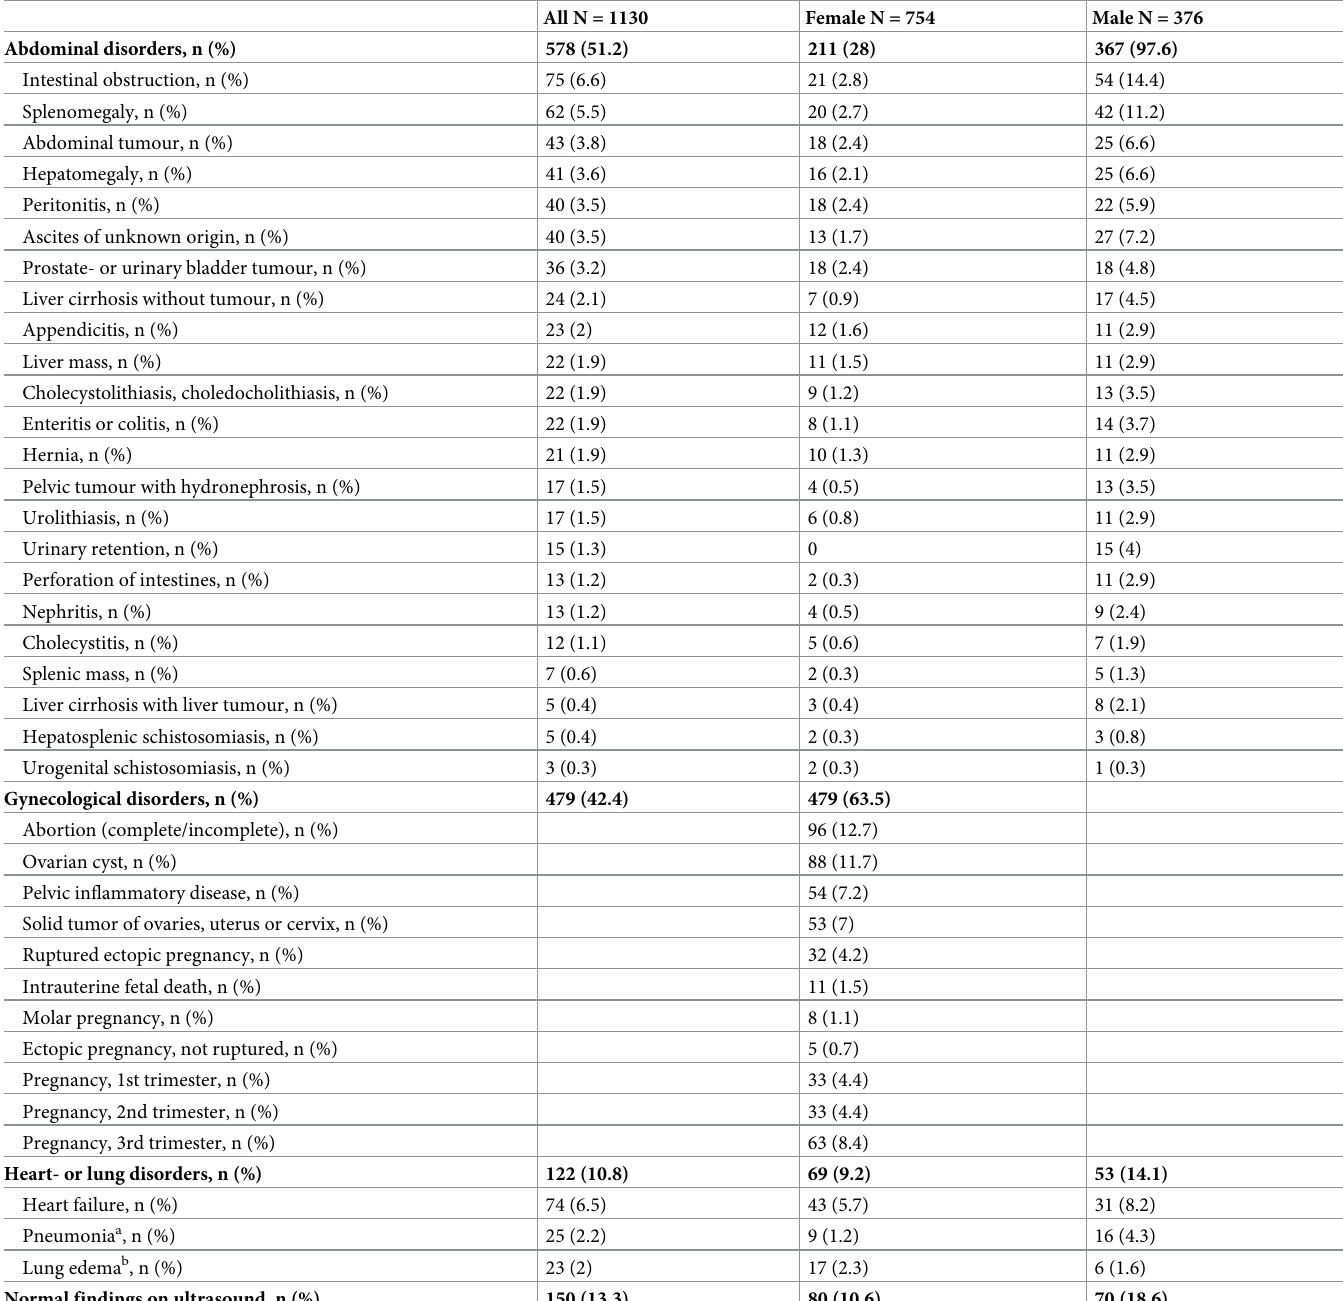
Table 4. Frequencies of 1326 diagnoses in 1130 patients with an abdominal